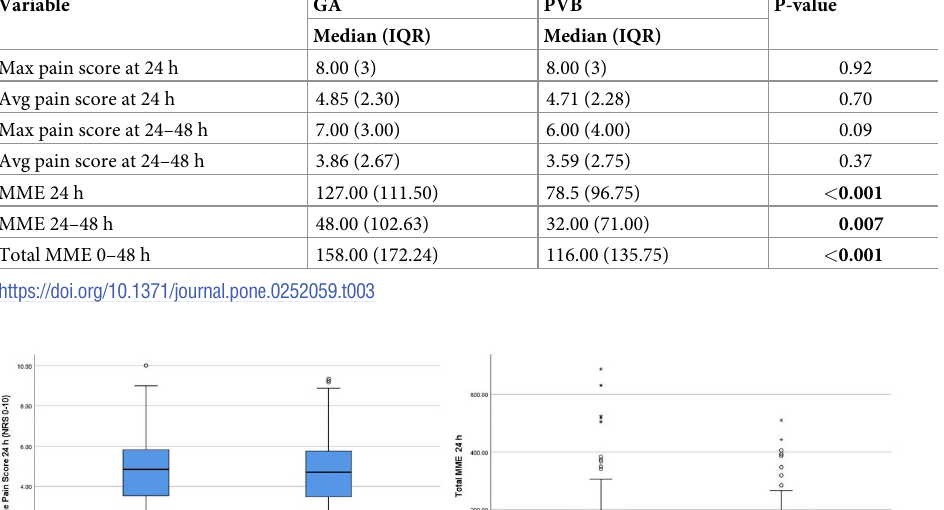
group characteristics after propensity score matching; all patients’ baseline characteristics and surgical factors no longer significantly differed among the two groups. Table 3 shows the results of postoperative pain scores and opioid requirements. The average pain scores in the first 24 hours did not differ significantly between the 2 groups [median in terms of oral MME for the first 24 hours was significantly lower in the PVB group compared to the GA group [median (IQR) PVB– 78.5 (96.75); GA-127.0 (111.5); p < 0.001]. Oral MME was also significantly lower in the PVB group in the 24 to 48-hour period [median (IQR)